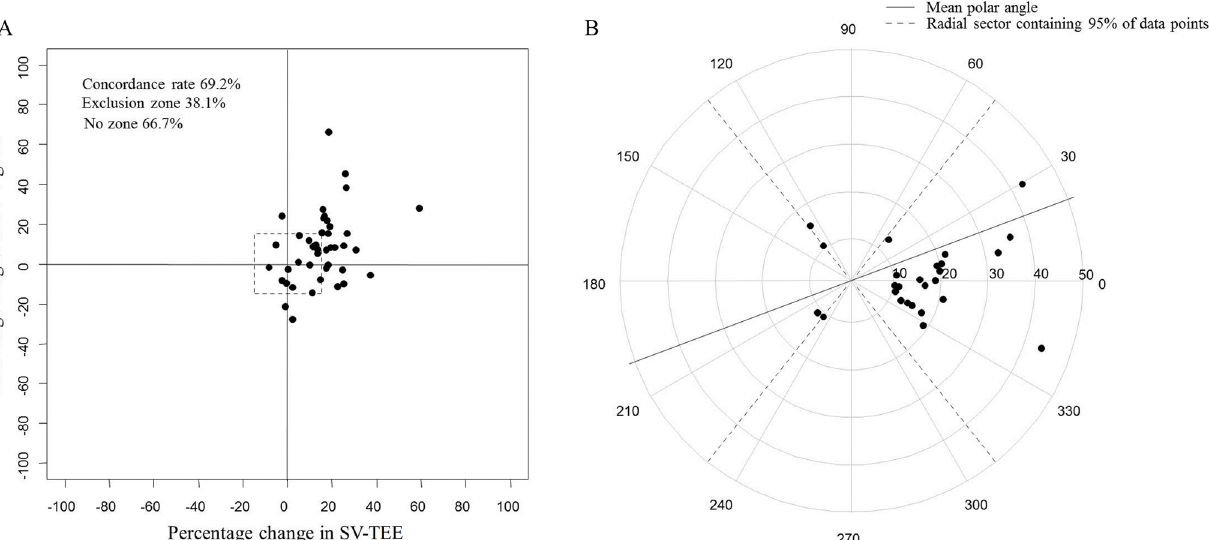
Fig 2. The four-quadrant plot and polar plot analysis. These figures identify an unreliable ability of the third-generation FloTrac/Vigileo ™ system to track changes in the stroke volume after fluid administration in the high systemic vascular resistance state observed during laparoscopic prostatectomy. (A) The four-quadrant plot analysis shows a concordance rate of 69.2%, when applying an exclusion zone of 15%. (B) The polar plot analysis shows a mean polar angle of 20.6° and a radial sector containing 95% of the data points of ± 51.5%, when applying an exclusion zone of 10%.